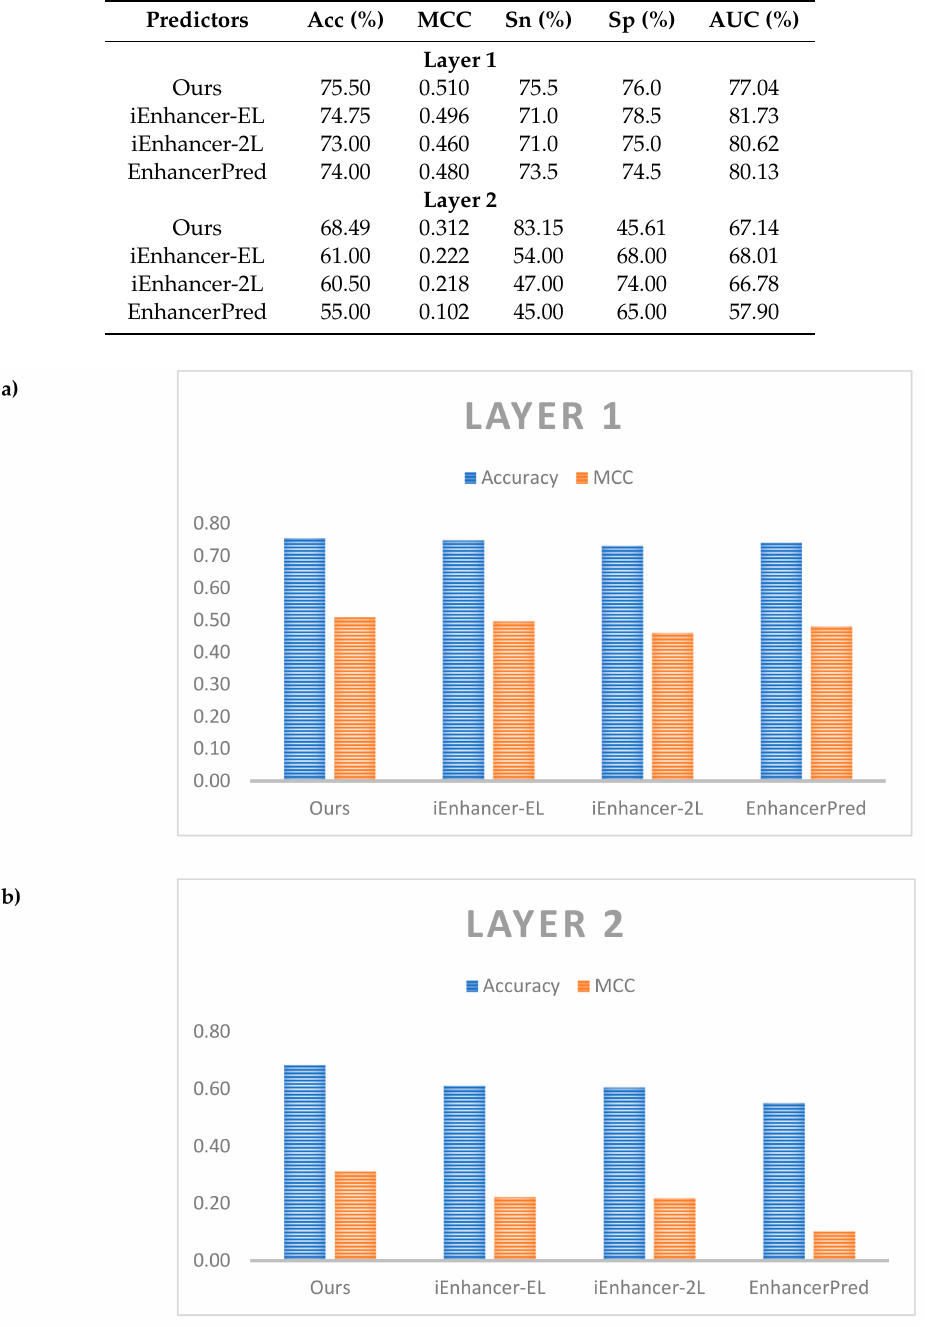
Figure5. Comparativeperformanceamongdifferentpredictors. ( a )Comparisononlayer1,( b )Comparison on layer